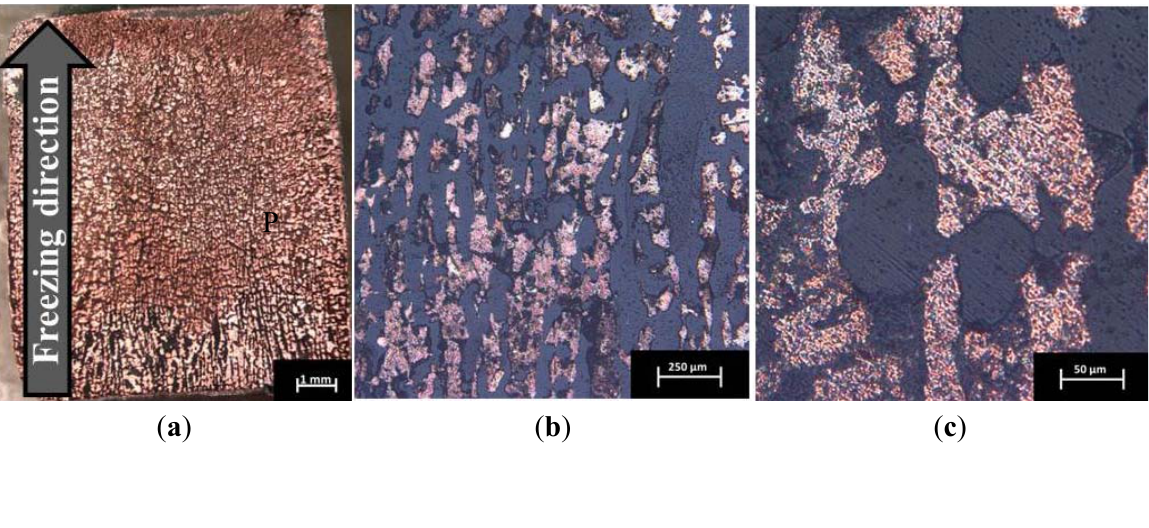
Figure 1. Optical micrographs of sample 1 obtained from a 10 vol % CuO suspension. Longitudinal cross-sections at ( a ) low, ( b ) medium and ( c ) high magnification. Copper is reddish and pores are filled with black